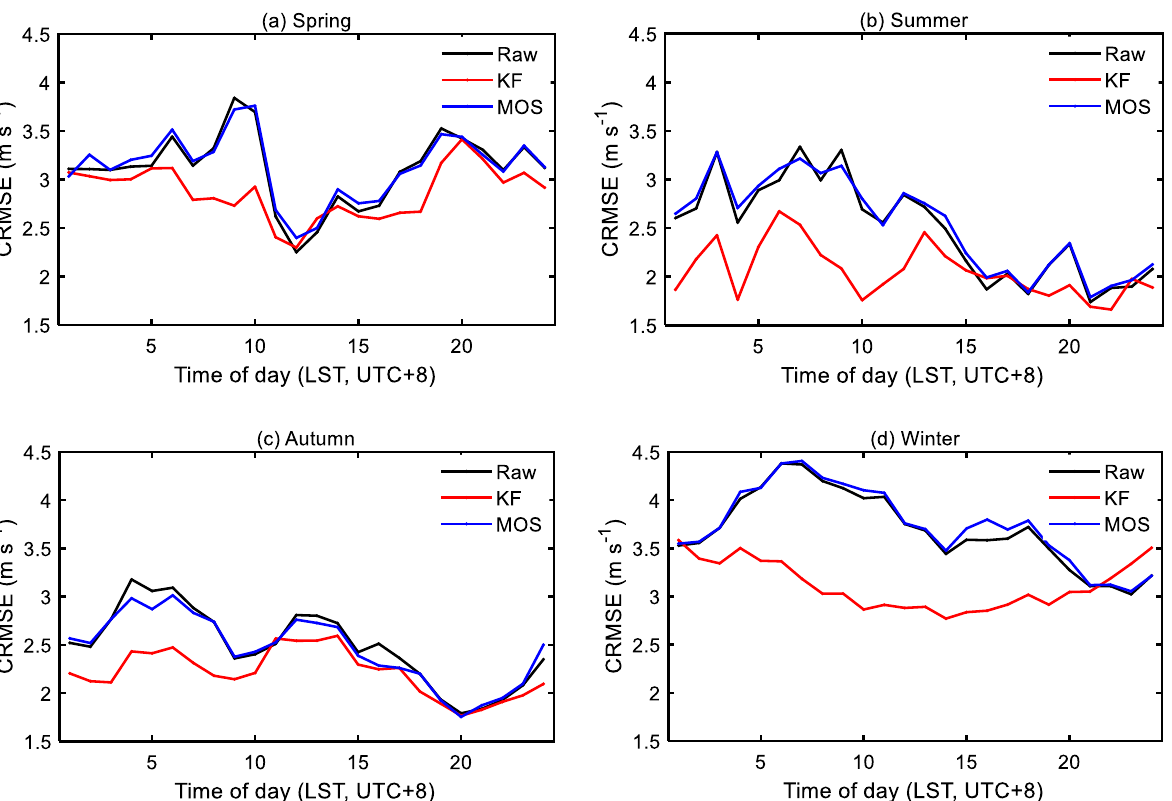
Fig. 4 Temporal evolution of CRMSE in a spring, b summer, c autumn, d winter for the raw forecasts, and the KF and MOS bias corrections across the 24 h of